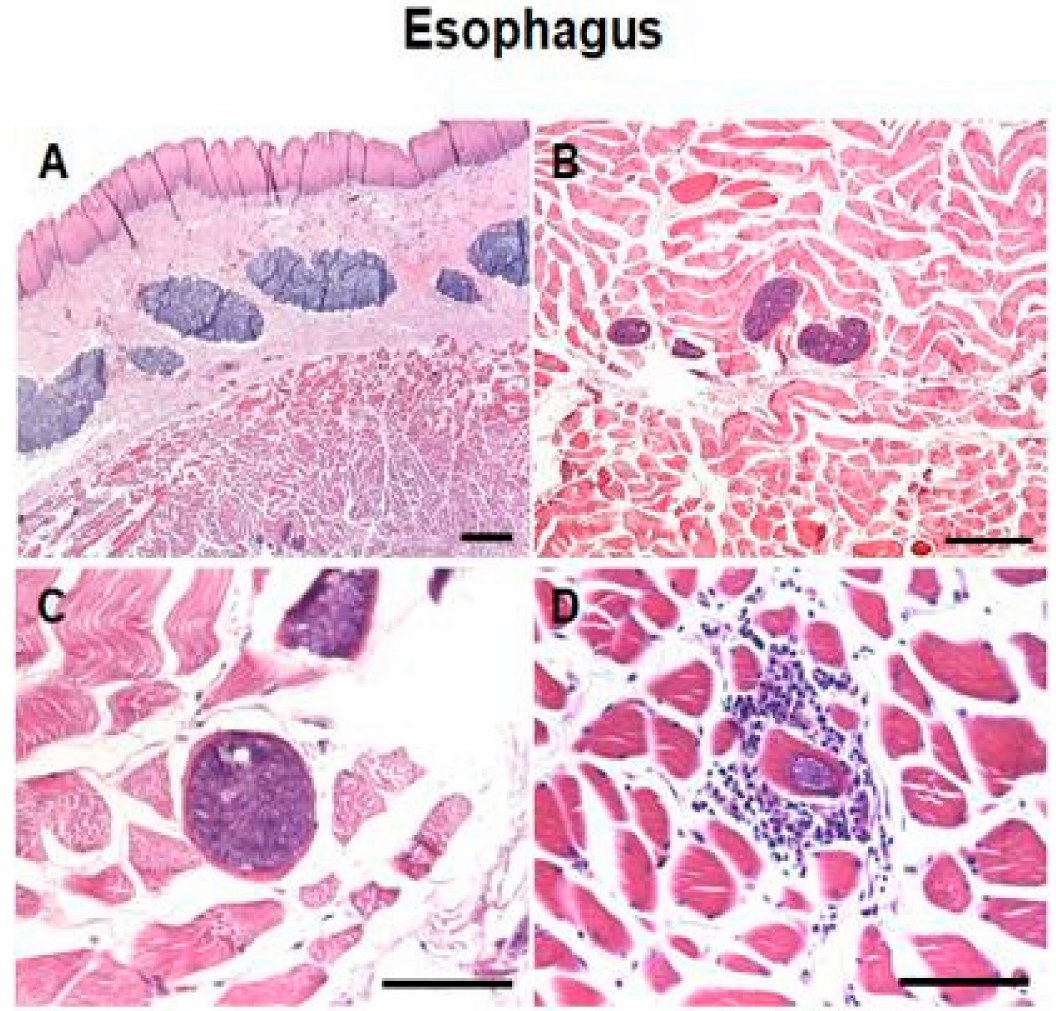
Figure 1. Photomicrograph of Sarcocystis in the esophagus. Hematoxylin and eosin stain. Encysted parasites in the muscle fibers of the esophagus without ( A – C ) or with ( D ) inflammatory cells infiltration. Bar ( A ) = 500 µ M. Bar ( B ) = 100 µ M. Bars ( C , D ) = 50 µ